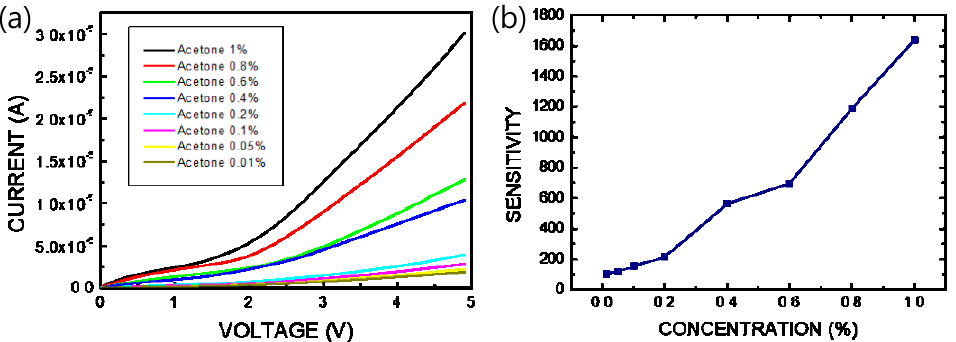
Figure 7. ( a ) I–V characteristics and ( b ) sensitivity of the pa-ZnO-doped CsPbBr 3 perovskite acetone sensors with treatment of annealing at 300 °C and pa-ZnO doping amount of 2 mg under ambient of various concentration of acetone.